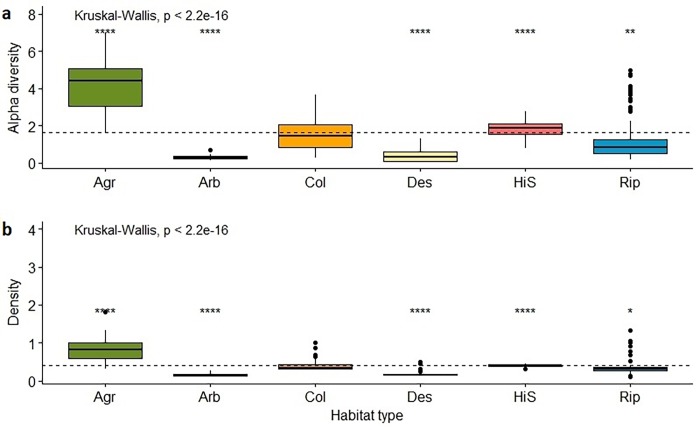
(a) Alpha diversity by habitat type and (b) bird density (individuals/ha) by habitat type, along an elevational gradient in the Dry Tropical Andes of northern Chile. Agr: Agricultural habitat; Arb: Arboreal shrubland habitat; Col: Columnar cactus habitat; Des: Desert habitat; HiS: Highland steppe habitat; Rip: Riparian habitat. Dotted lines indicate mean alpha diversity and mean density, respectively. Significant codes: <0.0001 ‘****’; <0.001 ‘***’; <0.01 ‘**’.